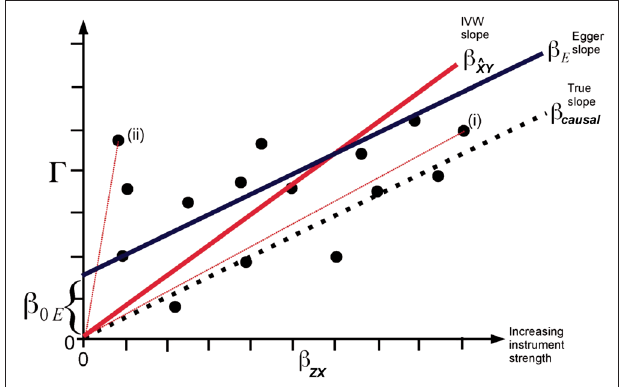
FiGuRe 2 | Plot of the SNP-outcome ( Γ ) on the y-axis vs. the SNP- exposure ( β ZX ) regression coefficients of potential genetic instruments (i.e., SNPs) of a Mendelian randomization analysis on the x-axis. The true causal effect represented by the slope β causal is shown by a dotted line, the inverse variance weighted (IVW) causal estimate β ˆ XY by a red line, and the MR Egger regression estimate β E by a dark blue line. The total SNP-outcome effect Γ is proportional to β ZX for valid instruments. In case of invalid instruments but when the InSIDE assumption holds, stronger instruments are on average expected to be closer to the true causal effect (i) than weak instruments ( ii ). The intercept β 0 E represents the overall directional pleiotropy of the instruments. The figure was adapted from the publication of Bowden et